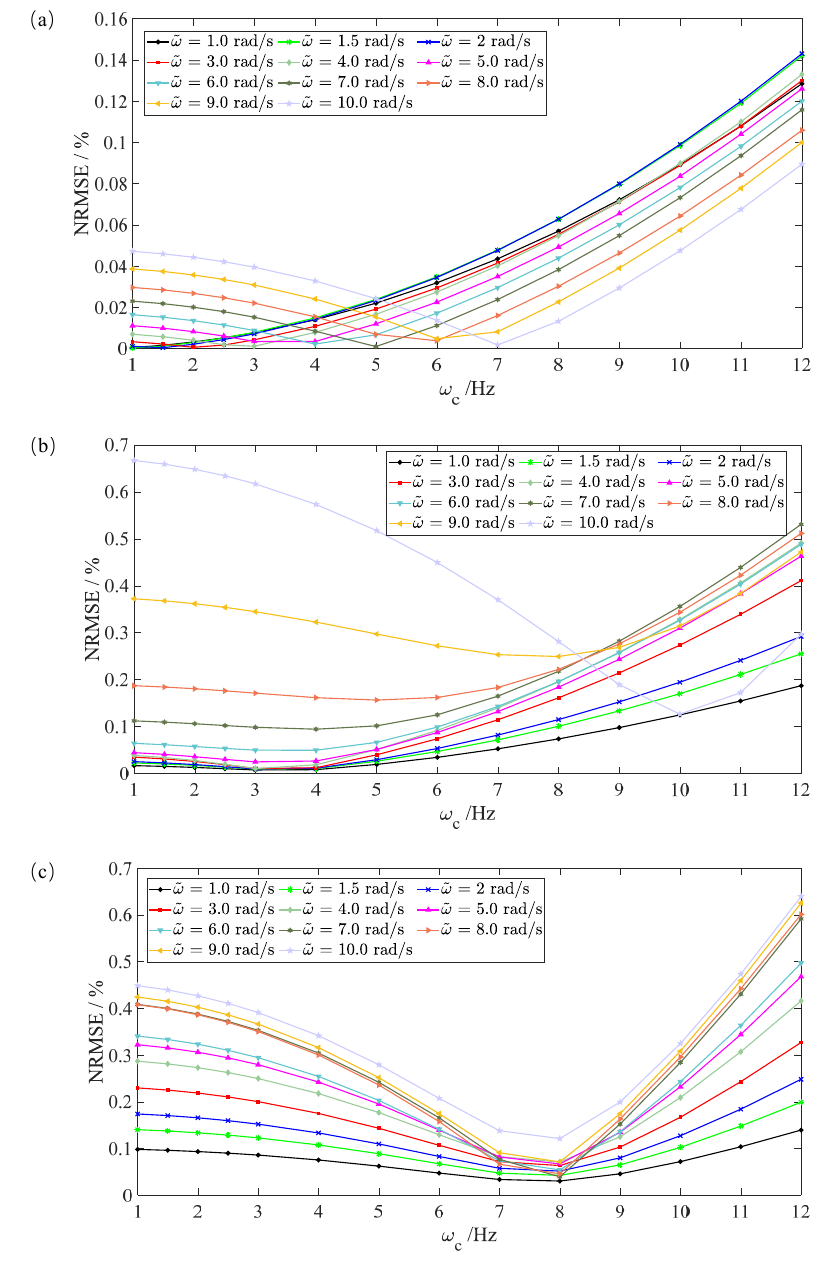
Figure 3. NRMSE curves vs . critical frequency ω c under harmonic excitation with different values of ˜ ω . ( a ) Model 1. ( b ) Model 8. ( c ) Model